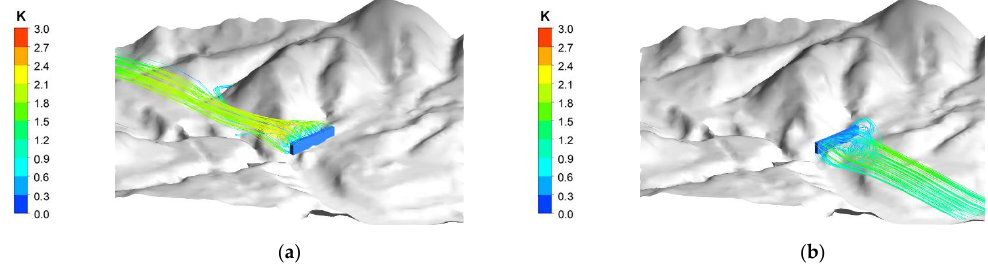
Figure 13. Streamline behind the shelterbelt over complex terrain ( a ) Northeast direction; ( b ) south- west direction.